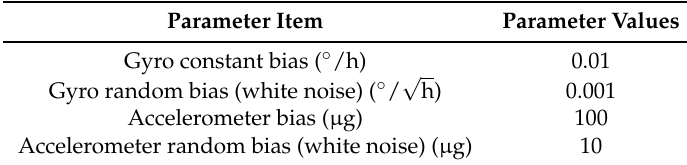
Table 1. Parameters of the gyroscope and